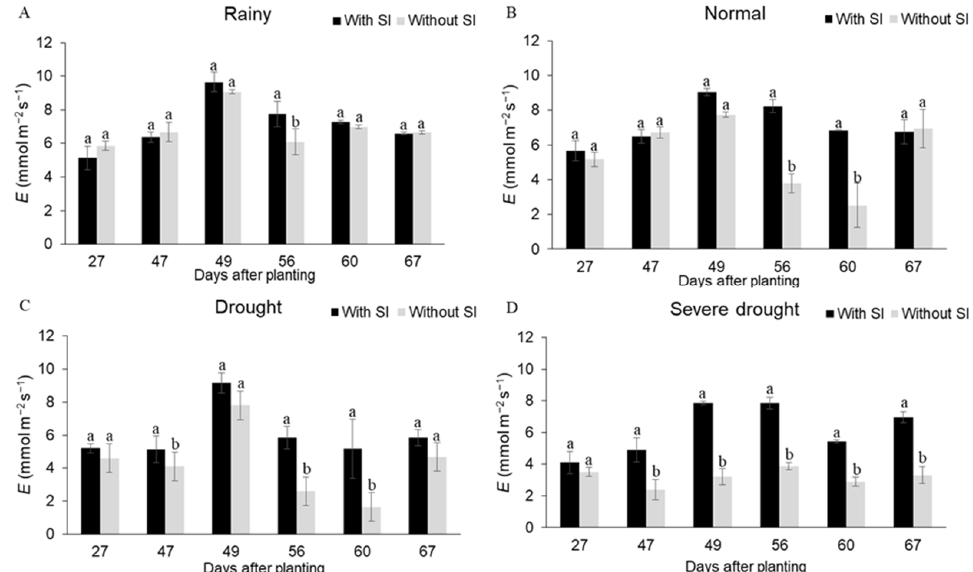
Figure 7. Transpiration rate of maize leaves under Rainy ( A ), Normal ( B ), Drought ( C ) and Severe drought ( D ) scenarios, showing sampling date and presence or absence of supplemental irrigation (SI) with brackish water of ECw = 4.5 dS m − 1 . For each sampling date, means followed by the same letters do not differ ( p ≥ 0.05) from each other according to the Tukey test. Error bars represent the standard error of the mean ( n = 4).